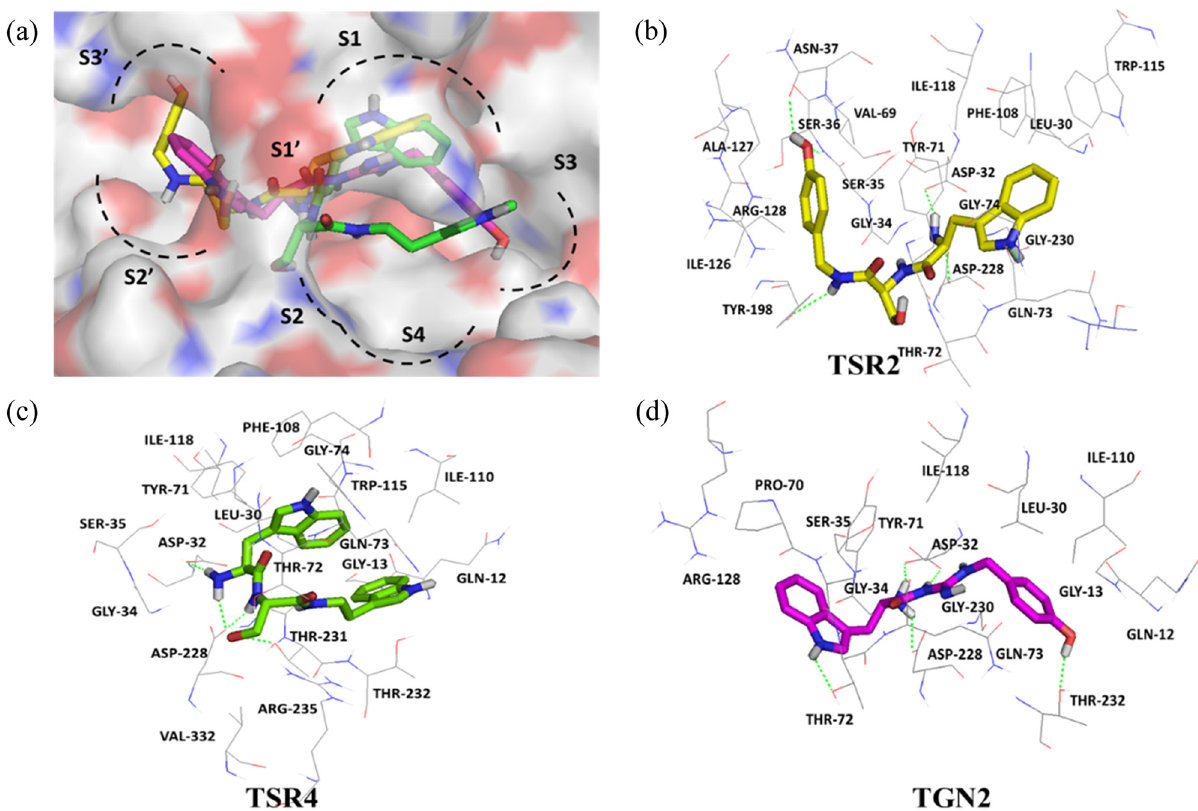
Figure 2: The binding modes of TSR2 ( yellow ) , TSR4 ( green ) , and TGN2 ( magenta ) in the active binding site of BACE1, overlay of docked poses ( a ) ; and the interacting residues, showing hydrogen bonds as green dotted lines ( b – d ) .